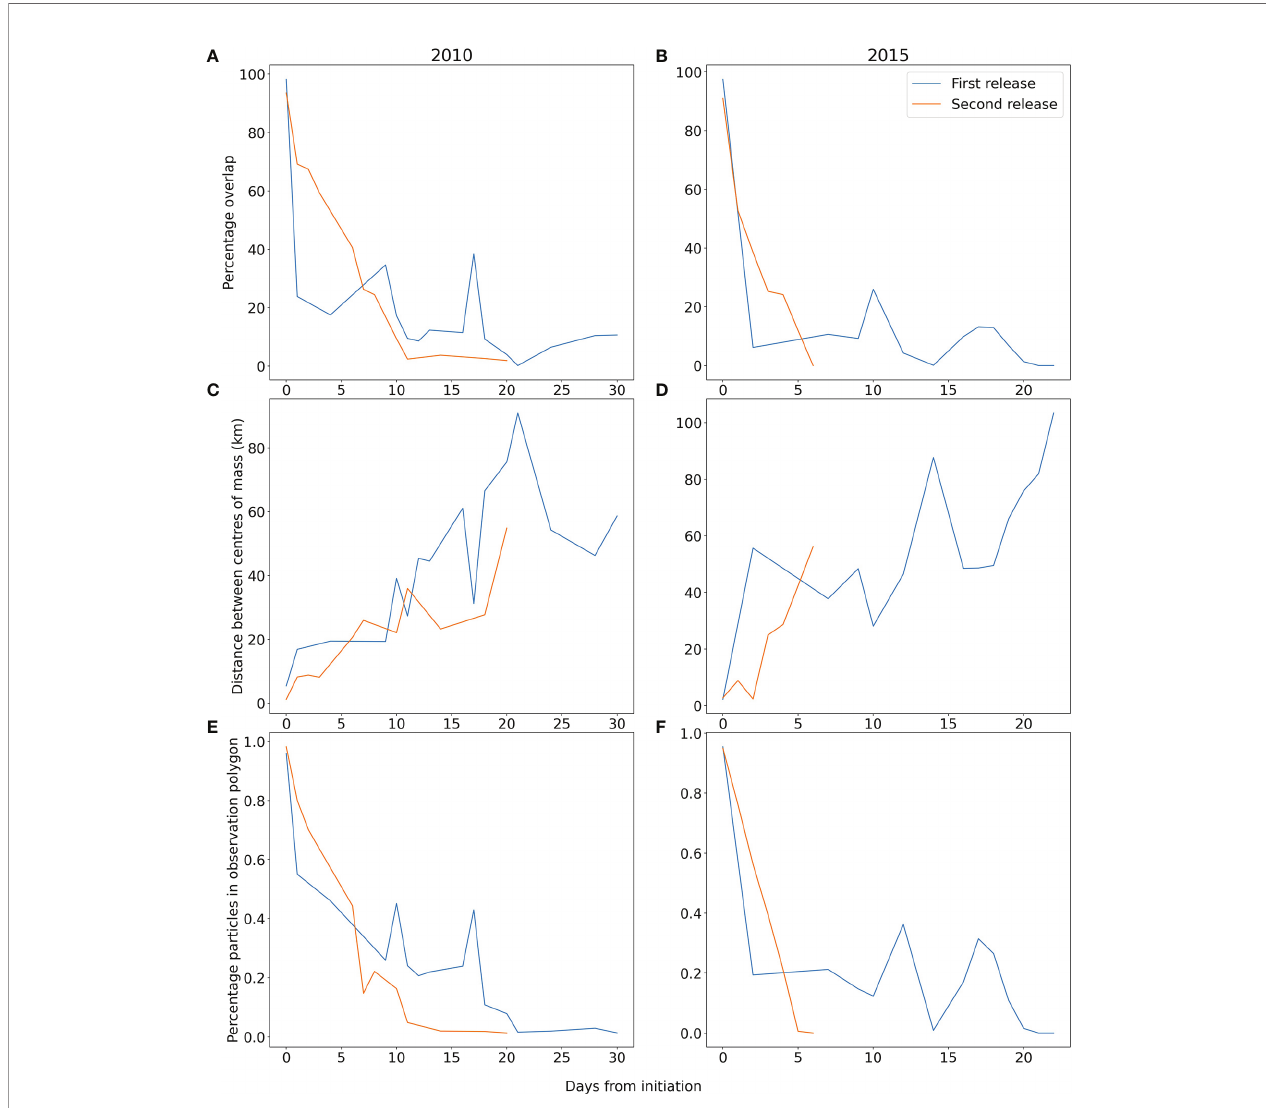
FIGURE 3 | Percentage overlap of polygons (A, B) , Distance between centres of mass (C, D) , and percentage of modelled particles within observation polygon (E, F) for each day after initiation for fi rst (blue) and second release (orange) in 2010 (A, C, E) and 2015 (B, D, F)